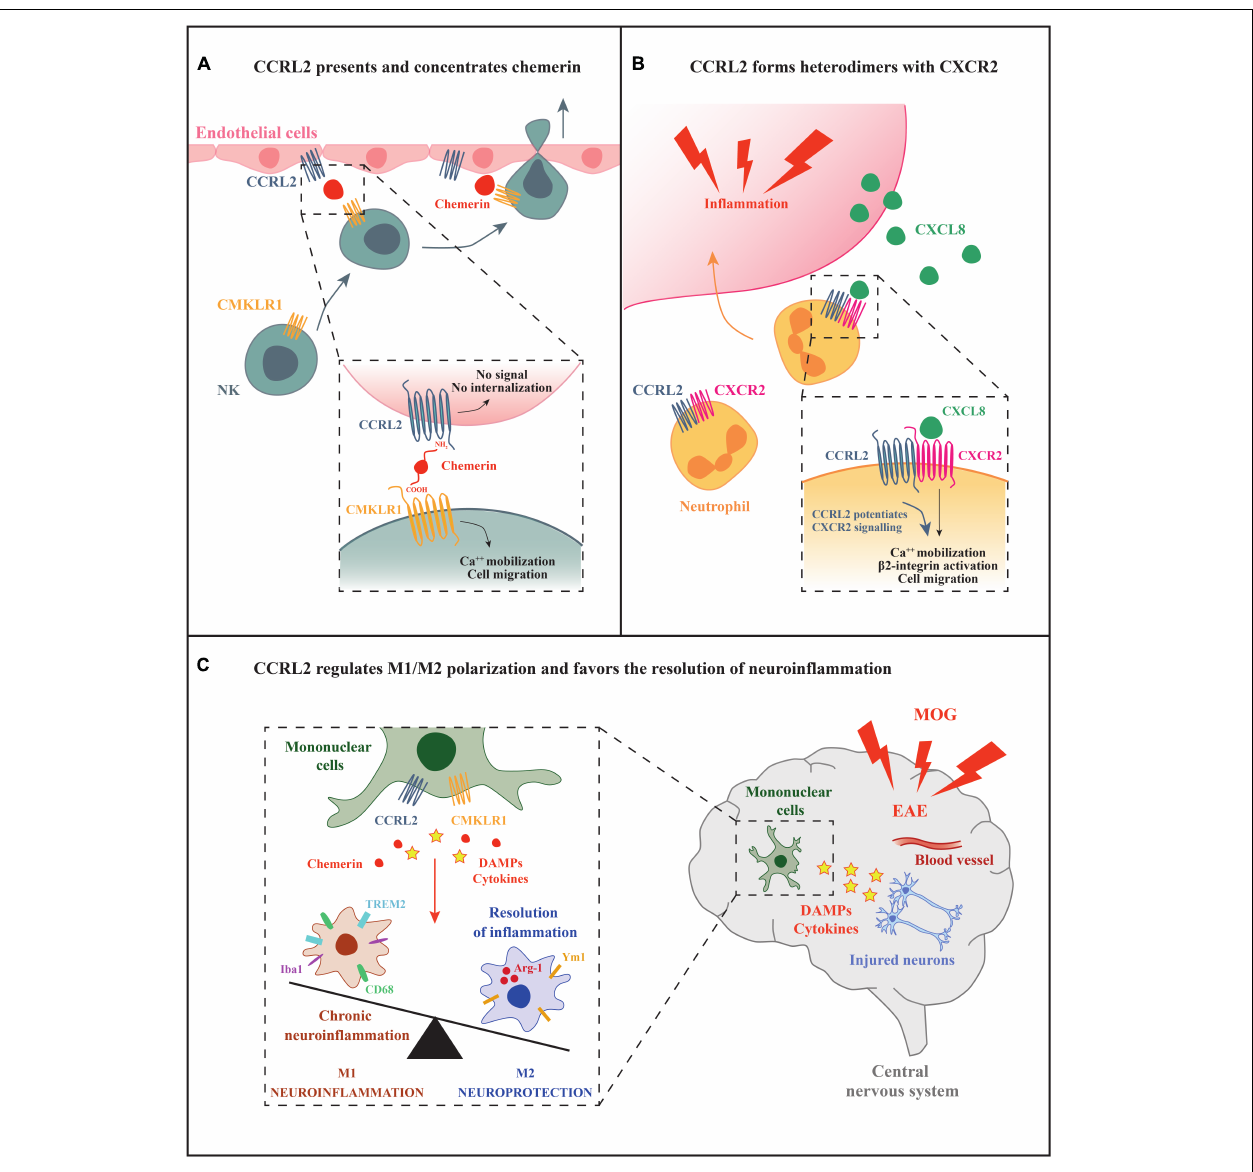
FIGURE 1 | Potential mechanisms of CCRL2 regulation of leukocyte migration. (A) CCRL2, expressed on barrier cells, such as epithelial or endothelial cells, can act as a chemerin presenting molecule. CCRL2 binding to the N-terminus leaves chemerin C-terminus available for the interaction with CMKLR1, the functional chemerin receptor expressed by different leukocyte subsets, such as NK cells. (B) CCRL2 regulates CXCR2 membrane expression and integrin-mediated arrest of neutrophils on endothelial cells forming CCRL2/CXCR2 heterodimers. (C) CCRL2 can favor the resolution of inflammation through the regulation of M1/M2 polarization